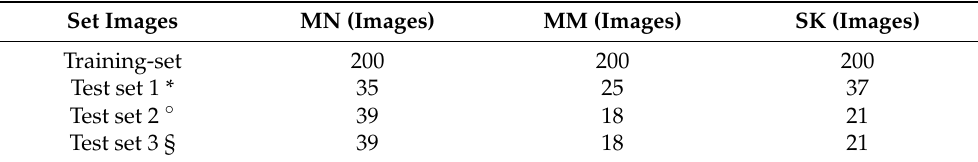
Table 1. Composition of the training set and the different data test sets employed in this study. Set Images MN (Images) MM (Images) SK (Images) Training-set 200 200 Test set 1 * Test set 2 ◦ Test set 3 § 39 18 21